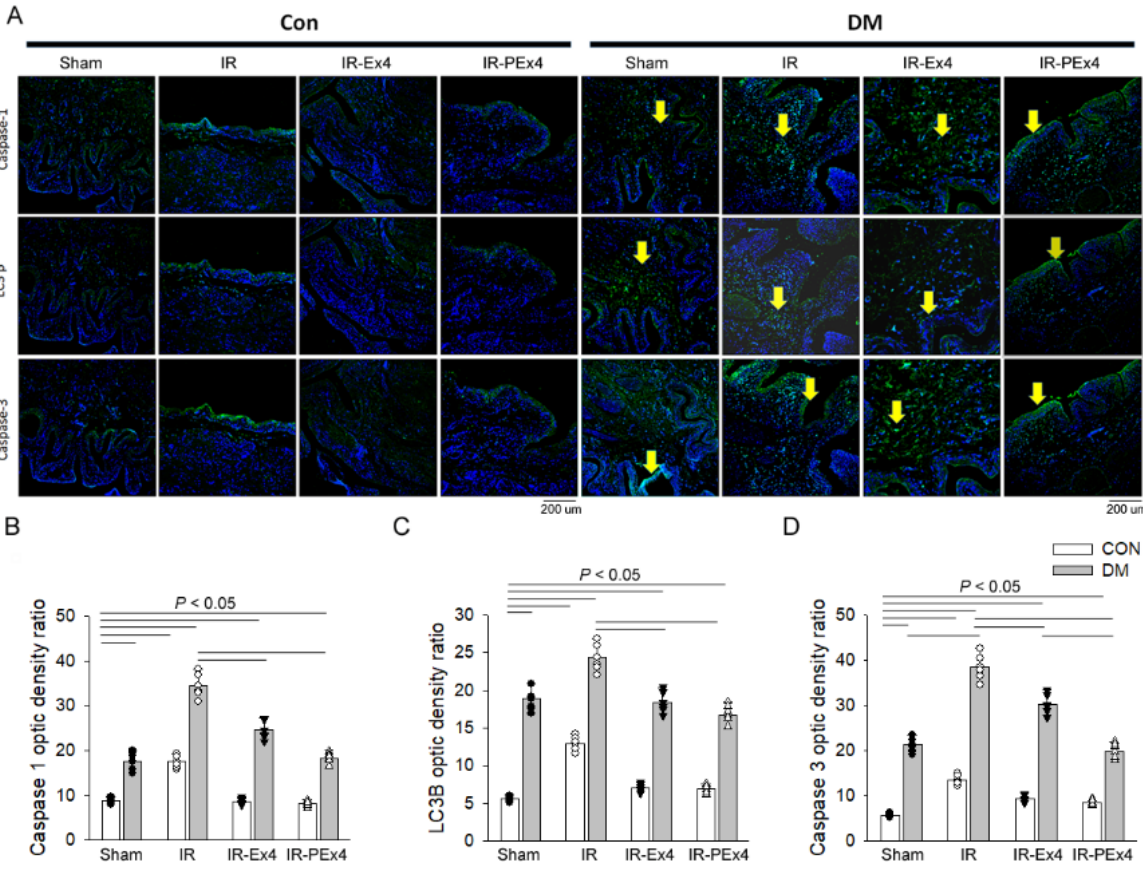
Figure 10. Effect of Ex-4 and PEx-4 treatment on the bladder expression of pyroptosis, autophagy and apoptosis in control and DM rats subjected to IR injury. ( A ) the level of green fluorescent intensity of Caspase-1-mediated pyroptosis, LC3B-mediated autophagy and Caspase-3-mediated apoptosis is determined with an immunofluorescent stain in the rat bladders. DM significantly enhanced bladder Caspase-1 ( B ), LC3B ( C ) and Caspase-3 ( D ) stains indicated by green fluorescence, whereas IR further and significantly increased Caspase-1, LC3B and Caspase-3 stains in the IR bladders of CON and DM rats as compared to respective CON and DM bladders. Ex-4 (IR-Ex4) and PEx-4 (IR-PEx4) treatment significantly reduced IR-enhanced Caspase-1, LC3B and Caspase-3 fluorescence in the bladders of CON and DM rats. Data are expressed as mean ± SEM in each group ( n = 6) using the single values. The statistical difference is indicated by the horizontal line with p < 0.05 between groups using one-way ANOVA, followed by Bonferroni’s post hoc test. Scale bar = 200 µ m. Each symbol represents one sample in different